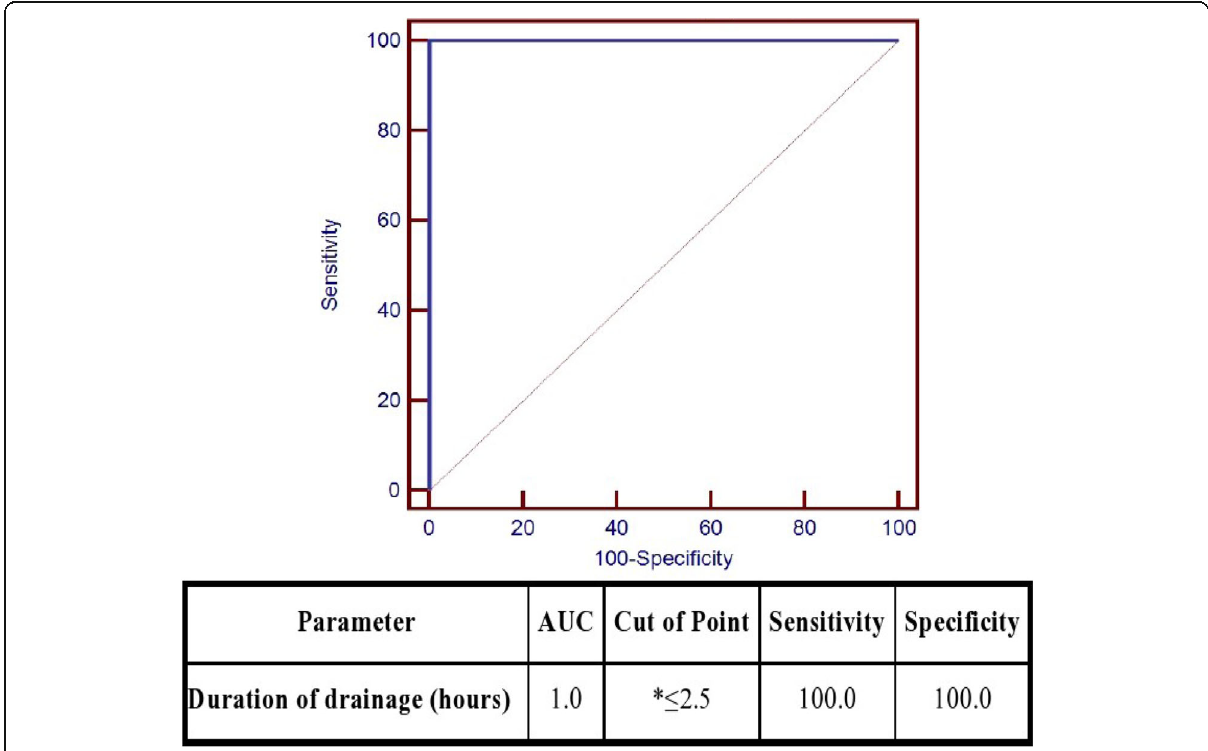
Fig. 1 ROC curve and coordinates for the best cutoff duration of pleural fluid aspiration till pleurodesis. *The shown hour was proposed for predicting pleurodesis success in our patient series. ROC, receiver operating characteristic; AUC, area under the